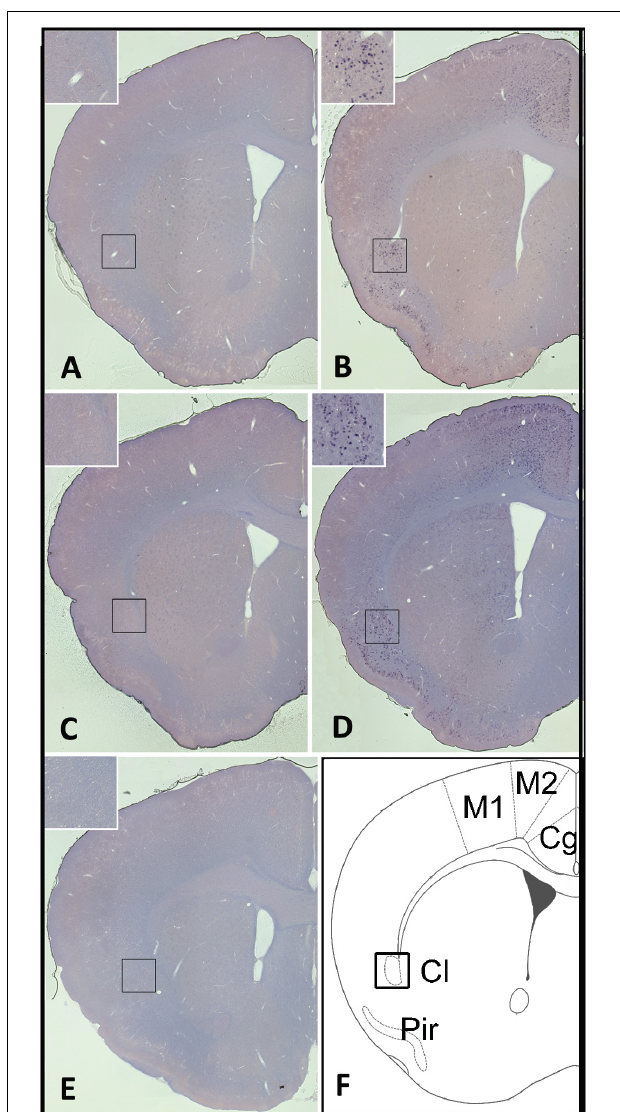
FIGURE 1 | Sleep loss induces homer1a expression in the claustrum, cingulate and piriform cortices. (A) Homer1a expression levels in 1hr sleep control claustrum enlarged; (B) Homer1a expression levels following 1 h sleep deprivation (SD), claustrum enlarged; (C) Homer1a expression levels in 3 h sleep diurnal control, claustrum enlarged; (D) Homer1a expression levels following 3 h SD; (E) In situ hybridization sense control; (F) diagram of brain slice showing pertinent regions. Bar size 1